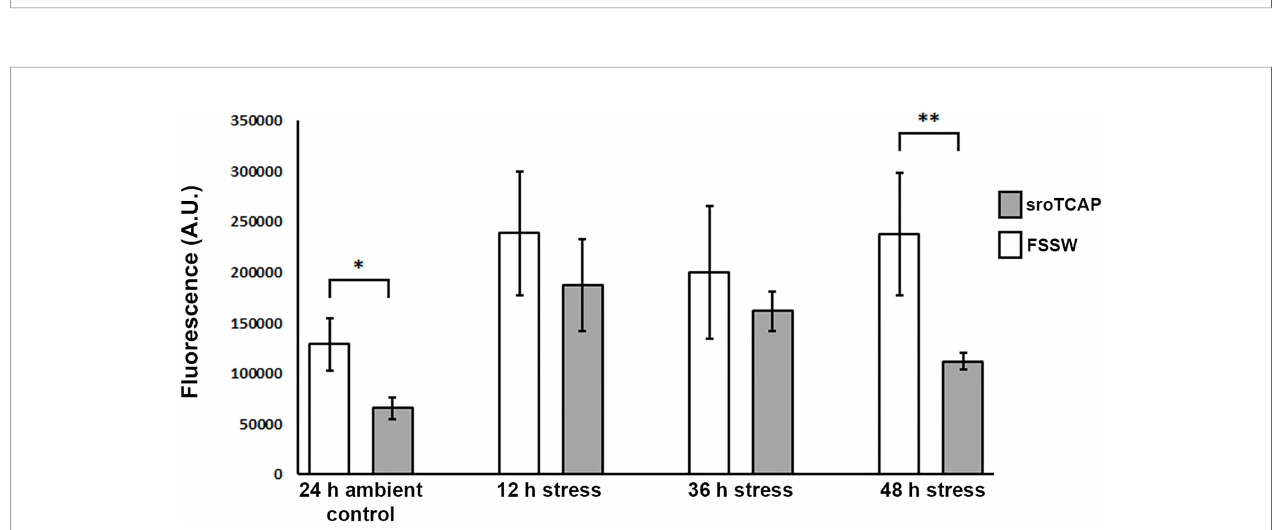
FIGURE 6 | ROS production in SRO hemocytes. Oysters were held in either ambient conditions (35 ppt and 22 ± 1°C) or stress conditions (15 ppt and 30 ± 1°C) for 12 – 48 h, and treated with either sroTCAP (5 pmol) or FSSW (negative control). Y-axis shows the arbitrary units of fl uorescence which re fl ects the ROS activity, higher fl uorescence demonstrates higher ROS and vice-versa (* P < 0.05, ** P <